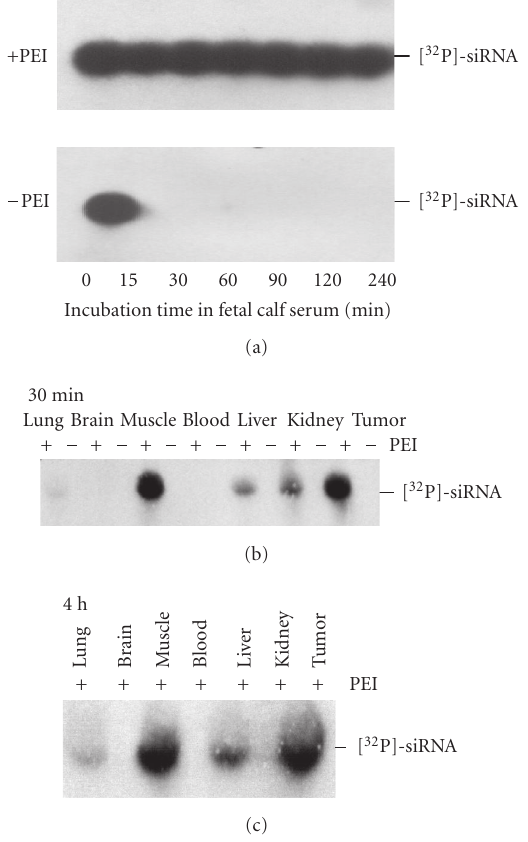
Figure 3: Protection and in vivo delivery of siRNAs upon PEI complexation. In [70] (a) in vitro protection of siRNAs against nucleolytic degradation. [ 32 P] end-labeled siRNAs, complexed (upper panel) or not complexed (lower panel) with PEI, were subjected to treatment with 1 % fetal calf serum at 37 ◦ C. At the time points indicated, the samples were analysed by agarose gel electrophoresis, blotting, and autoradiography. The bands represent full-length siRNA molecules indicating that PEI complexation leads to the e ffi cient protection of siRNAs while noncomplexed siRNAs are rapidly degraded. (b,c) In vivo delivery of intact siRNAs upon PEI complexation. [ 32 P]-labeled siRNAs, complexed (+) or not complexed ( − ) with PEI, were injected IP into mice bearing subcutaneous SKOV-3 ovarian carcinoma cell tumor xenografts, and after 30 min (b) or 4h (b) total RNA from various organ and tissue homogenates was prepared and subjected to agarose gel electrophoresis prior to blotting and autoradiography. The bands represent intact [ 32 P]-labeled siRNA molecules which for several hours are mainly found in tumor and muscle as well as in liver and, time-dependently, in kidney. Only little siRNA amounts are detected in the lung and traces in the